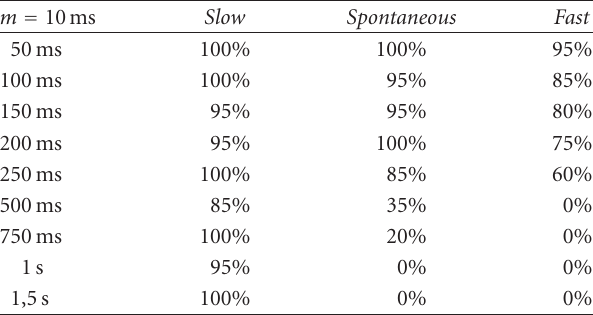
Figure 11: Wearable setup used in human-based tests. Table 3: Human-based test results.